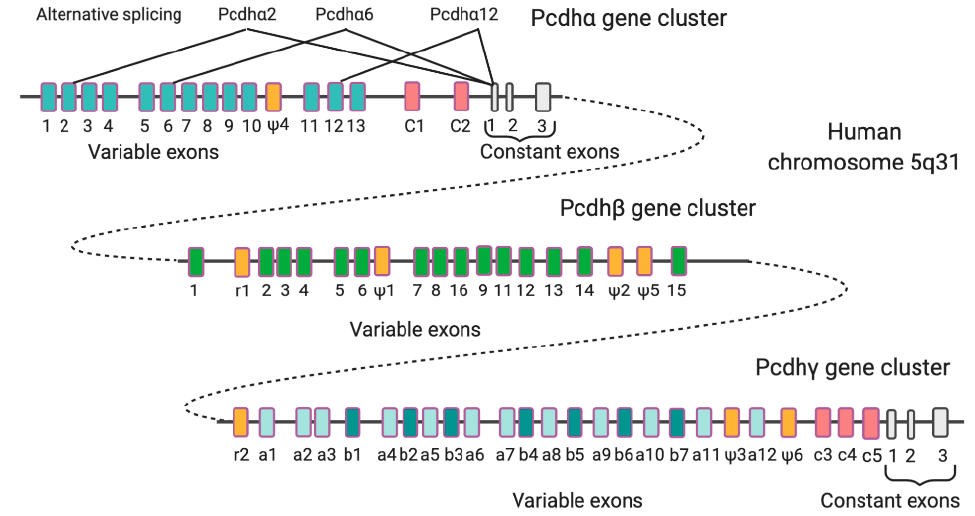
Figure 2. Genomic organization of human PCDH gene clusters. Shown are PCDH α , PCDH β , and PCDH γ gene clusters. Each gene family contains multiple tandem variable exons indicated in a different color; only PCDH α and PCDH γ share common constant region exons (grey) that form the cytoplasmic tail. In all the three gene clusters are present relic (r) or pseudogene ( ψ ) variable region sequences (orange). The generation of PCDHa2, PCDHa6, and PCDHa12 through alternative splicing is indicated as an example of exon selection that produces various isoforms.